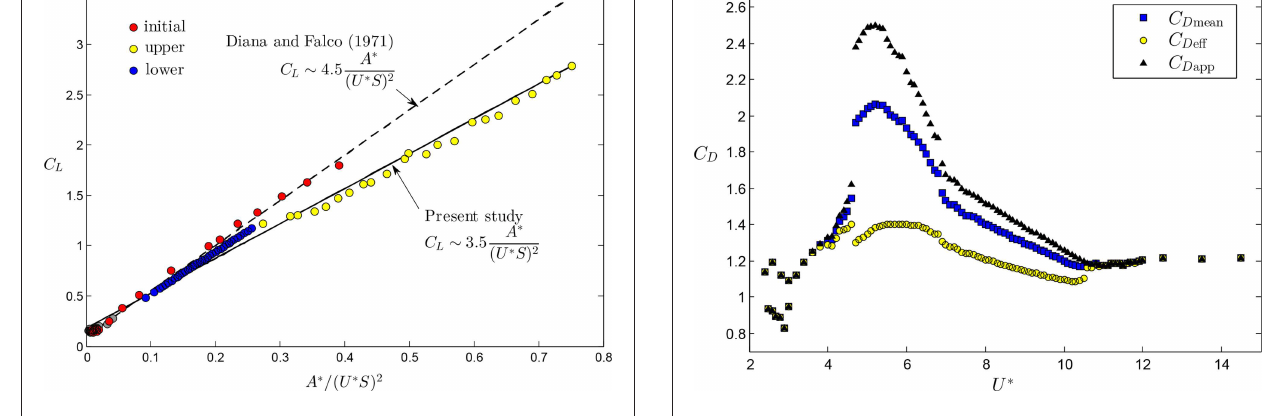
4.3, (B) U ∗ 5.5, (C) U ∗ 6.8, (D) = = =